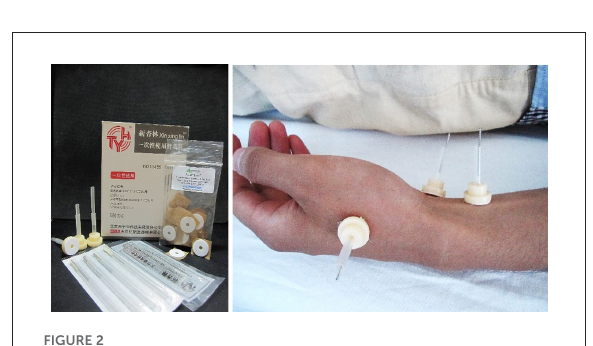
both the AA group and the SA group (Table 1, Figure